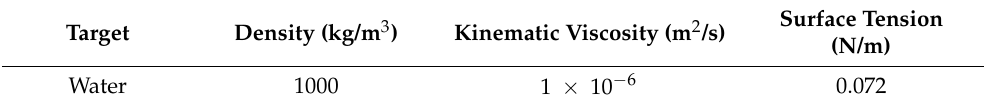
Table 3. Fluid material